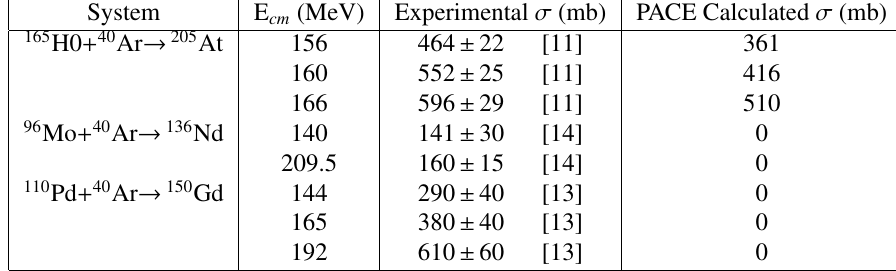
Table 1. Experimental fission cross sections reported in the literature compared with PACE calculations for di ff erent systems. A strong disagreement is observed for some